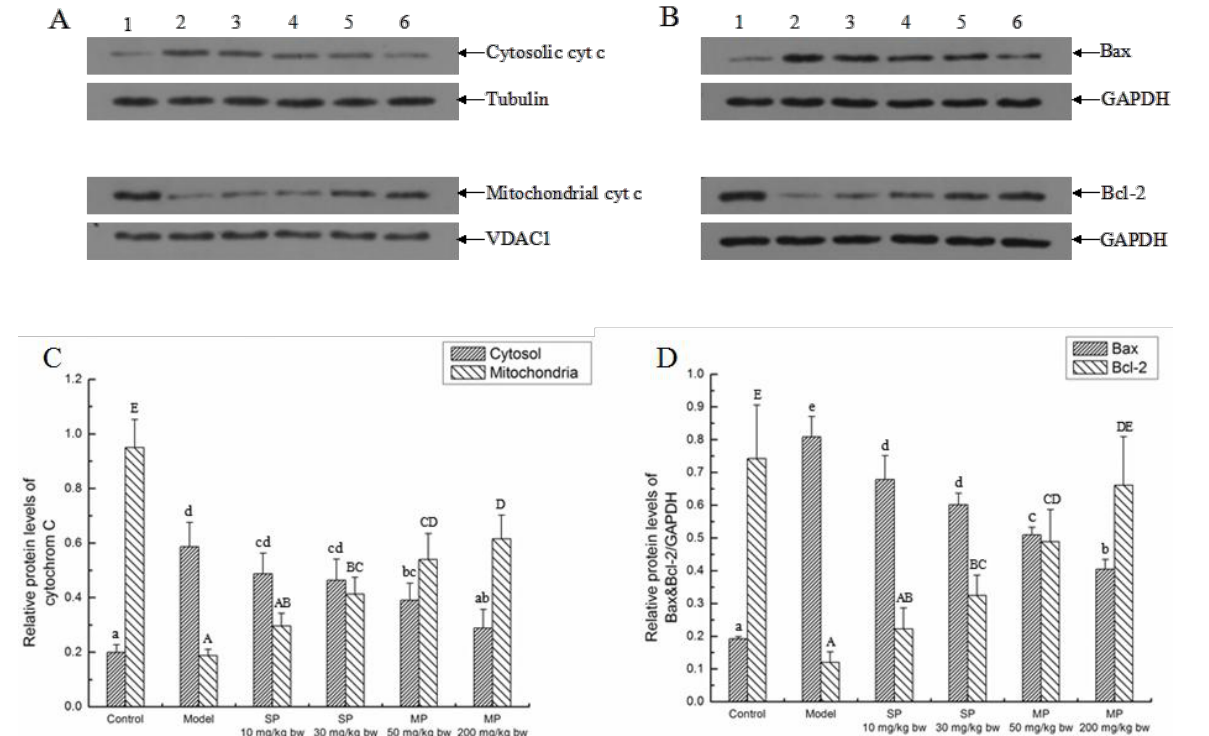
Figure 5. The relative protein expressions of cytochrome c, Bcl-2 and Bax in each group. Representative western blots for ( A ) cytochrome c; ( B ) Bcl-2 and Bax. Tubulin and VDAC1 were used as internal controls for cytosol and mitochondria, respectively. GAPDH was used as internal control for liver tissue; ( C ) Relative protein level of cytochrome c/Tubulin and cytochrome c/VDAC1; ( D ) Relative protein levels of Bax & Bcl-2/GAPDH. Values not sharing a common letter (a, b, c, d, e) in ( C , D ) differ significantly of cytochrome c/Tubulin and Bax/GAPDH at p < 0.05, separately. Values not sharing a common letter (A, B, C, D, E) in ( C , D ) differ significantly of cytochrome c/VDAC1 and Bcl-2/GAPDH at p < 0.05, separately. SP, synthetic pentapeptide; MP, mixed corn peptides. Numbers 1–6 indicate groups of Control, Model, SP-10 mg/kg bw, SP-30 mg/kg bw, MP-50 mg/kg bw and MP-200 mg/kg bw